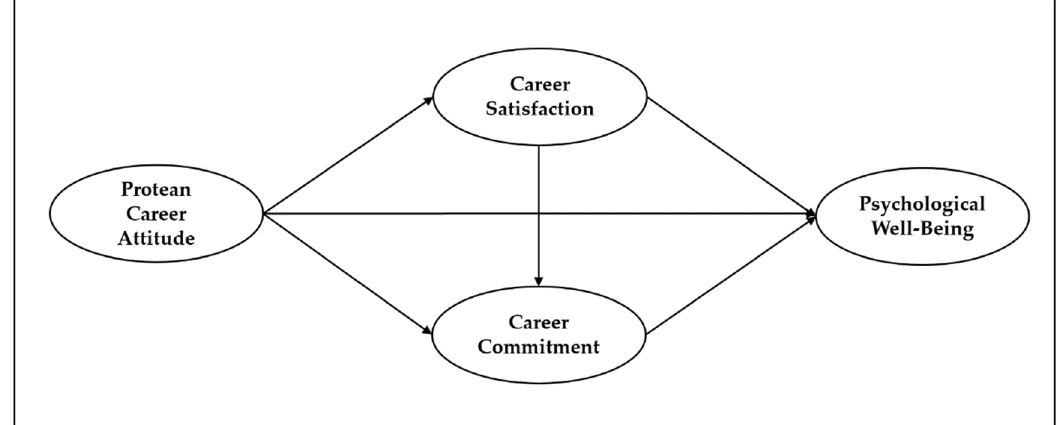
Figure 1. Hypothesized research model.